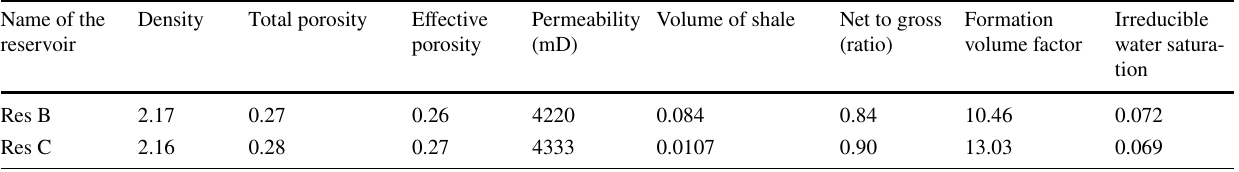
Table 2 Petrophysical parameter values Name of the